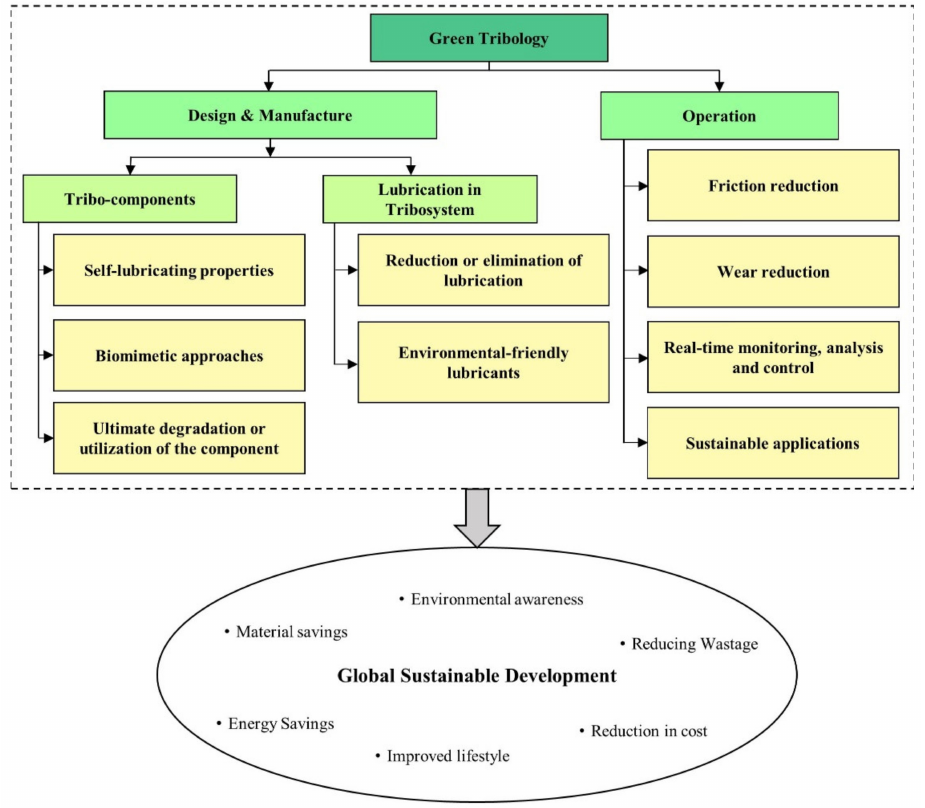
Figure 1. Green tribology and its important characteristics towards global sustainable